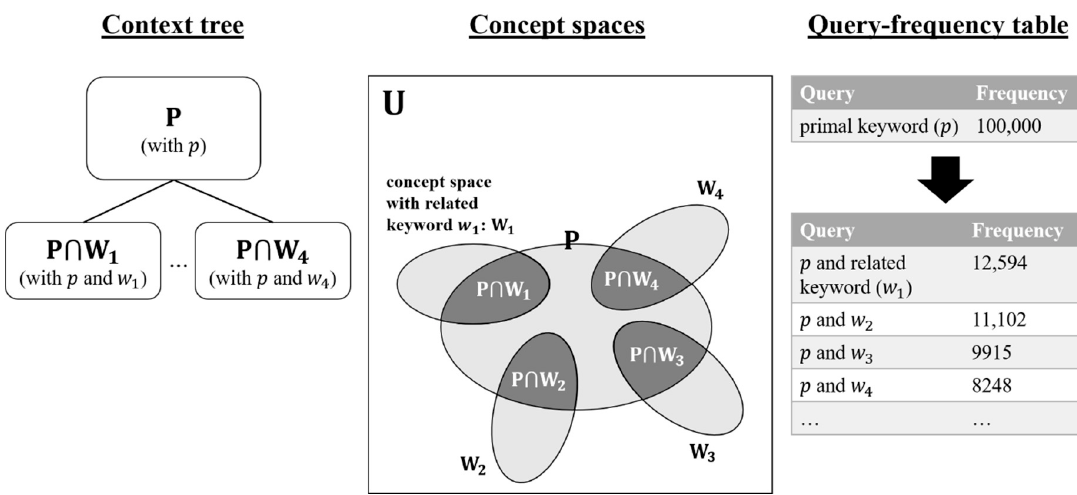
Figure 2. Initializing the Context Tree using the primal